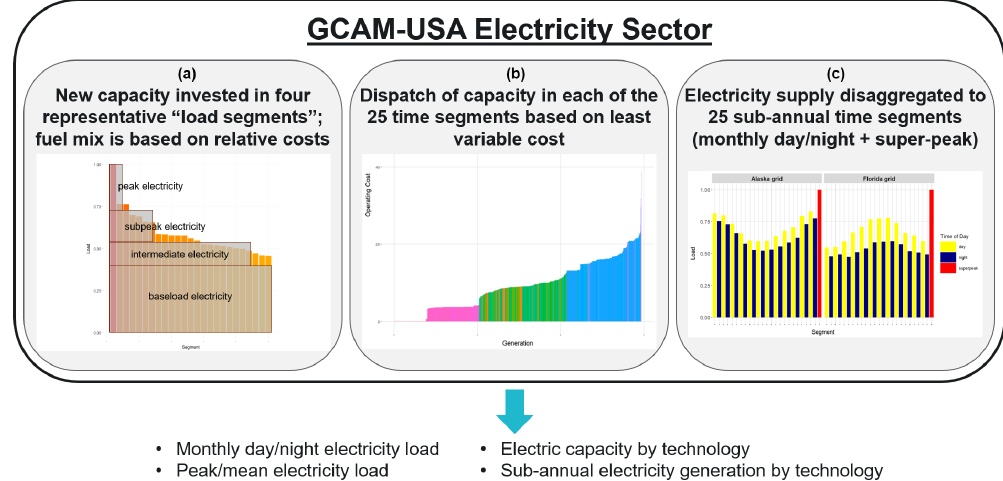
Figure 2. Conceptual diagram of new GCAM-USA electric power